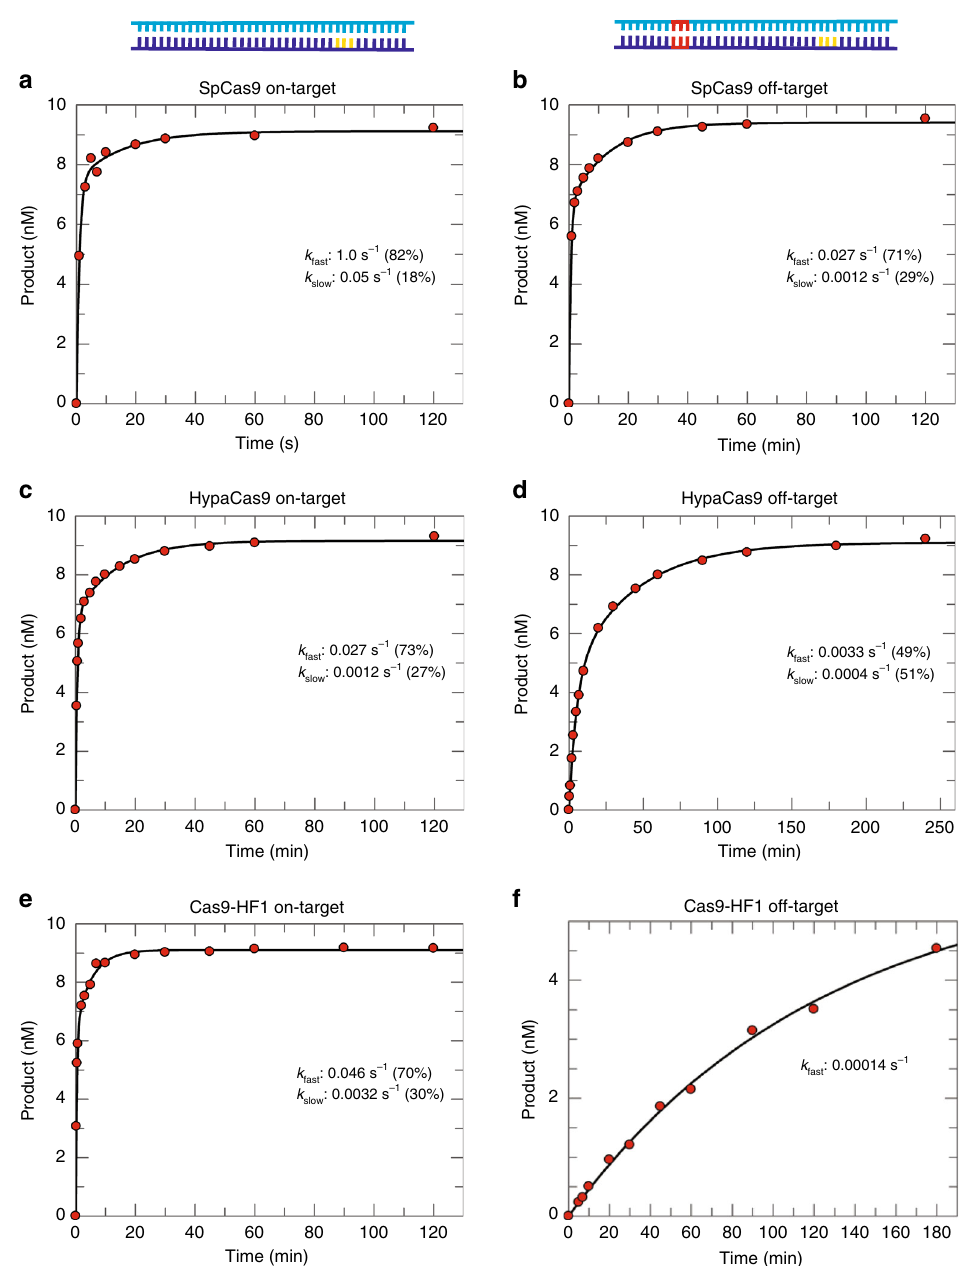
Fig. 1 PAM-distal mismatches dramatically slow cleavage by HypaCas9 and Cas9-HF1. Schematic of target DNA substrate. PAM site is orange; target sequence is blue; mismatches in the PAM distal region are red; gRNA is colored gray; cleavage sites are shown as red and blue vertical lines for the HNH and RuvC domains, respectively; tC o labeled site at position − 16 nt or − 1 nt in the non-target strand is green. Cy3 and Cy5 labeled sites at position − 6 nt and − 16 nt in the target strand and non-target strand, respectively, are underlined. A time course of cleavage of on-target DNA (10 nM) was monitored with 28 nM of each enzyme. Data were fi t to a double-exponential equation and the percentage of the total signal occurring with each decay rate is indicated. SpCas9 cleavage of on-target ( a ) (from Gong et al. 15 ) and off-target ( b ) DNA. c, d HypaCas9 cleavage with on-target ( c ) and off-target ( d ) DNA. e, f Cas9-HF1 cleavage of on-target ( e ) and off-target ( f ) DNA. Data in f were fi t to a single-exponential